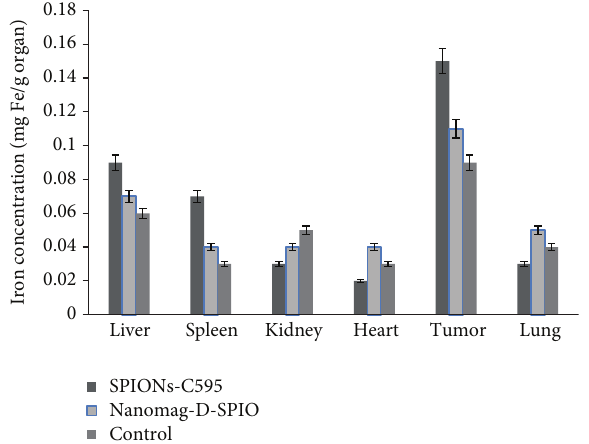
Figure 10: Biodistribution of iron uptakes in different studied organs 24 h after injection of